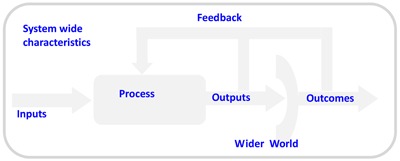
Basic system model [4].